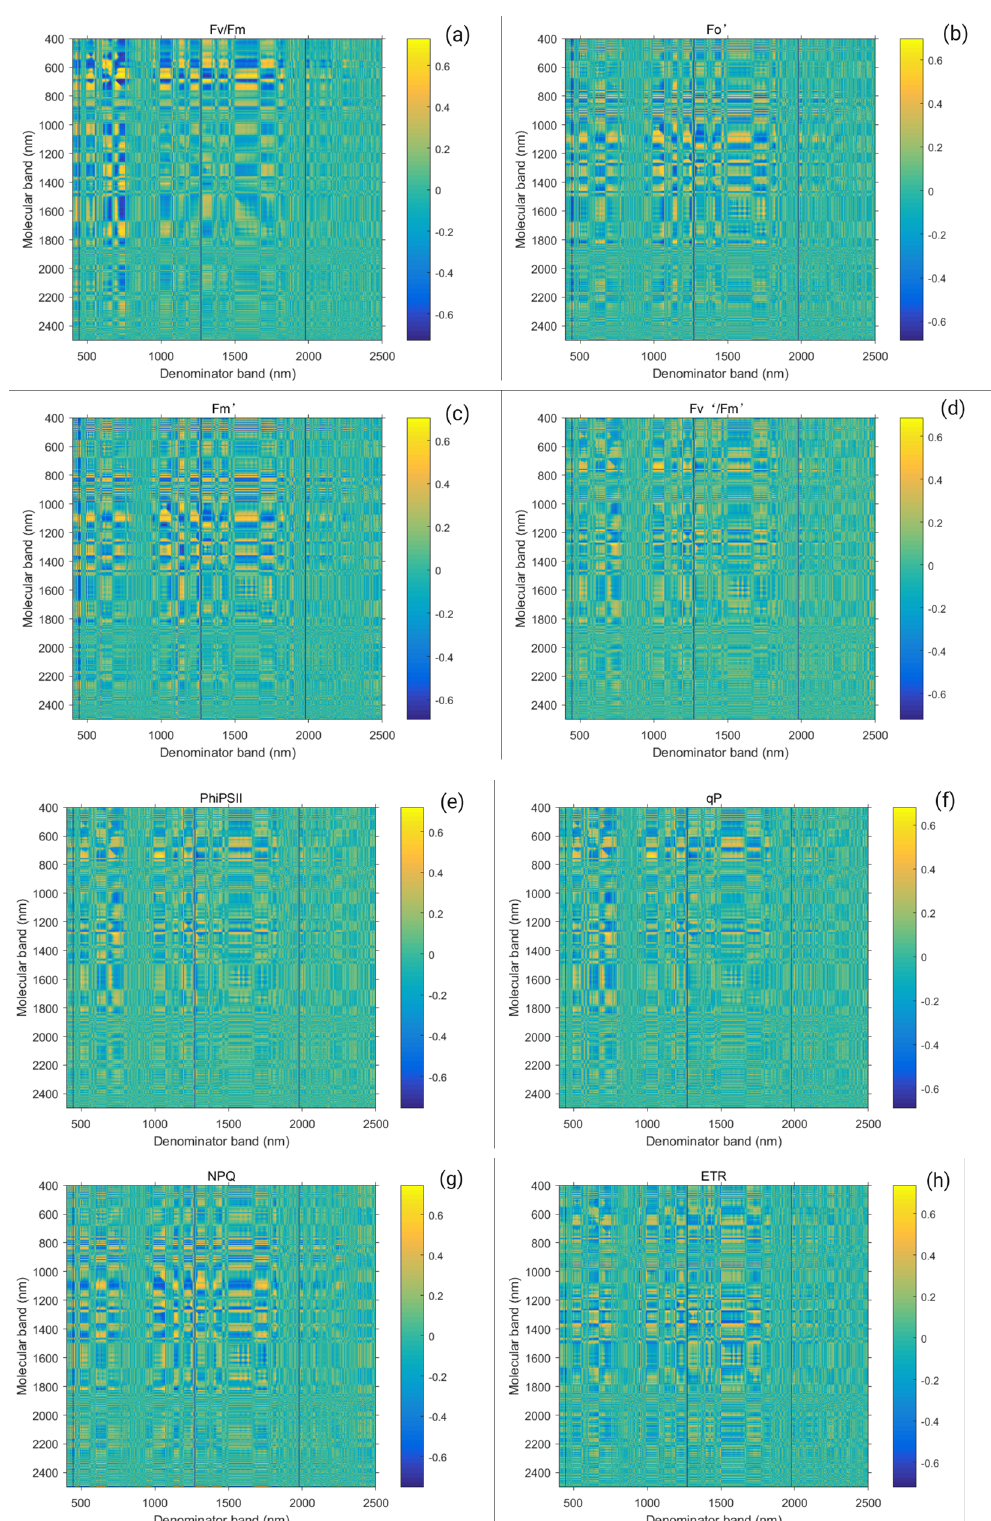
( c ), Fv (cid:48) / Fm (cid:48) ( d ), Φ PSII ( e ) , qP ( f ), NPQ ( g ), ETR ( h )) and first-order differential spectrum ratio Figure 9. Correlation coefficient of chlorophyll fluorescence parameters( 𝐹𝑣/𝐹𝑚 ( a ) 、 𝐹𝑜’ ( b ) 、 𝐹𝑚’ ( c ) 、 𝐹𝑣’/𝐹𝑚’ ( d ) 、 coefficient under water and salt 𝛷𝑃𝑆𝐼𝐼 ( e ) 、 𝑞𝑃 ( f ) 、 𝑁𝑃𝑄 ( g ) 、 𝐸𝑇𝑅 ( h )) and first-order differential spectrum ratio coefficient under water and salt conditions.